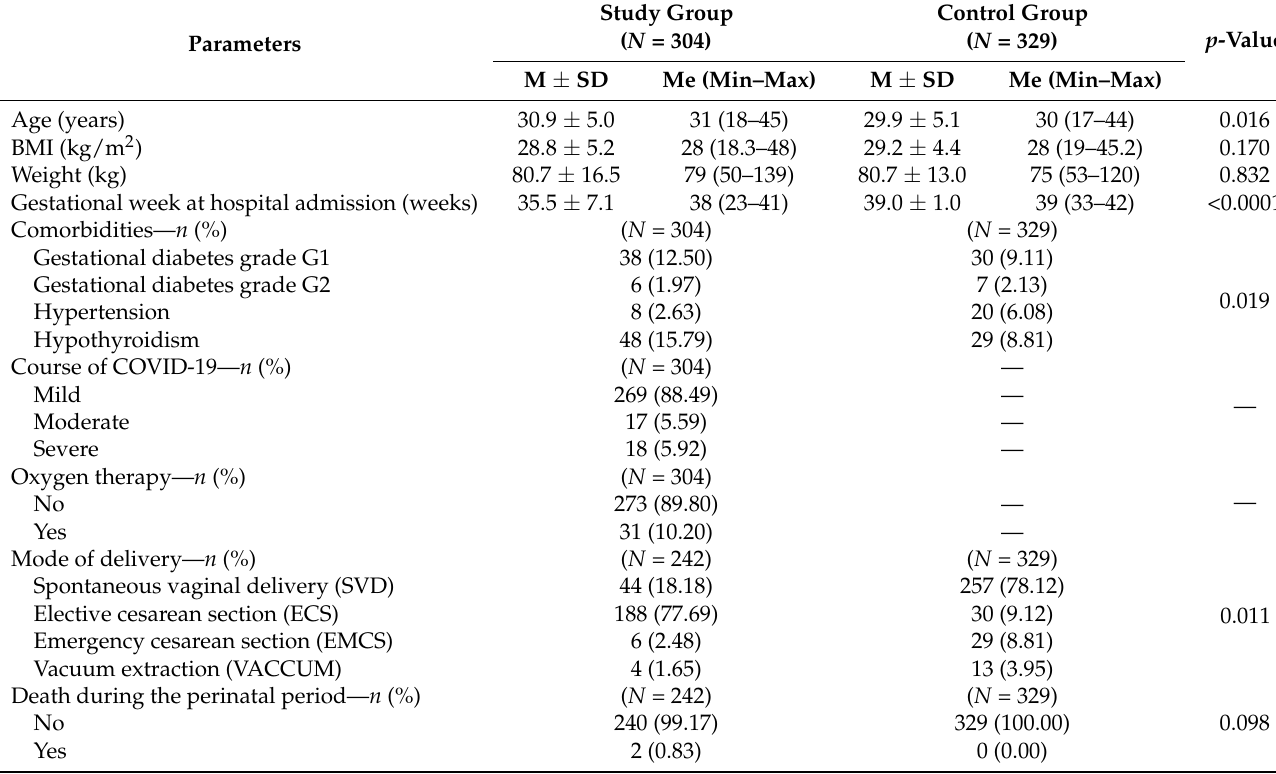
Table 1. Characteristics of the study